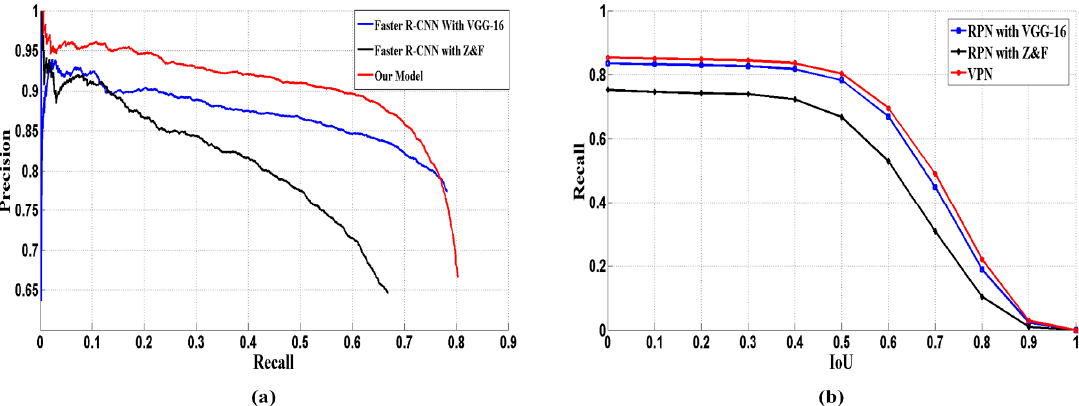
Figure 10. Comparisons of three detection models ( a ) precision-recall curve ( b ) recall vs. IoU curve.